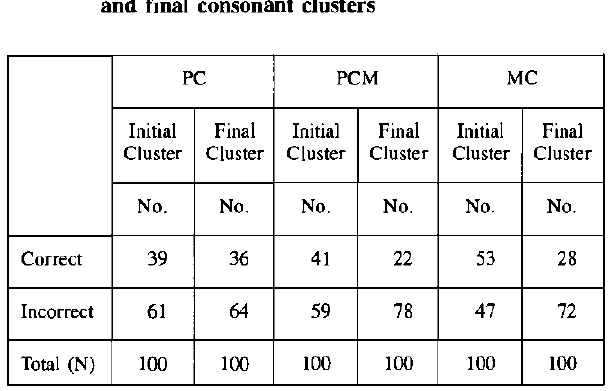
Table 1 Frequency count of correct versus incorrect initial and final consonant clusters